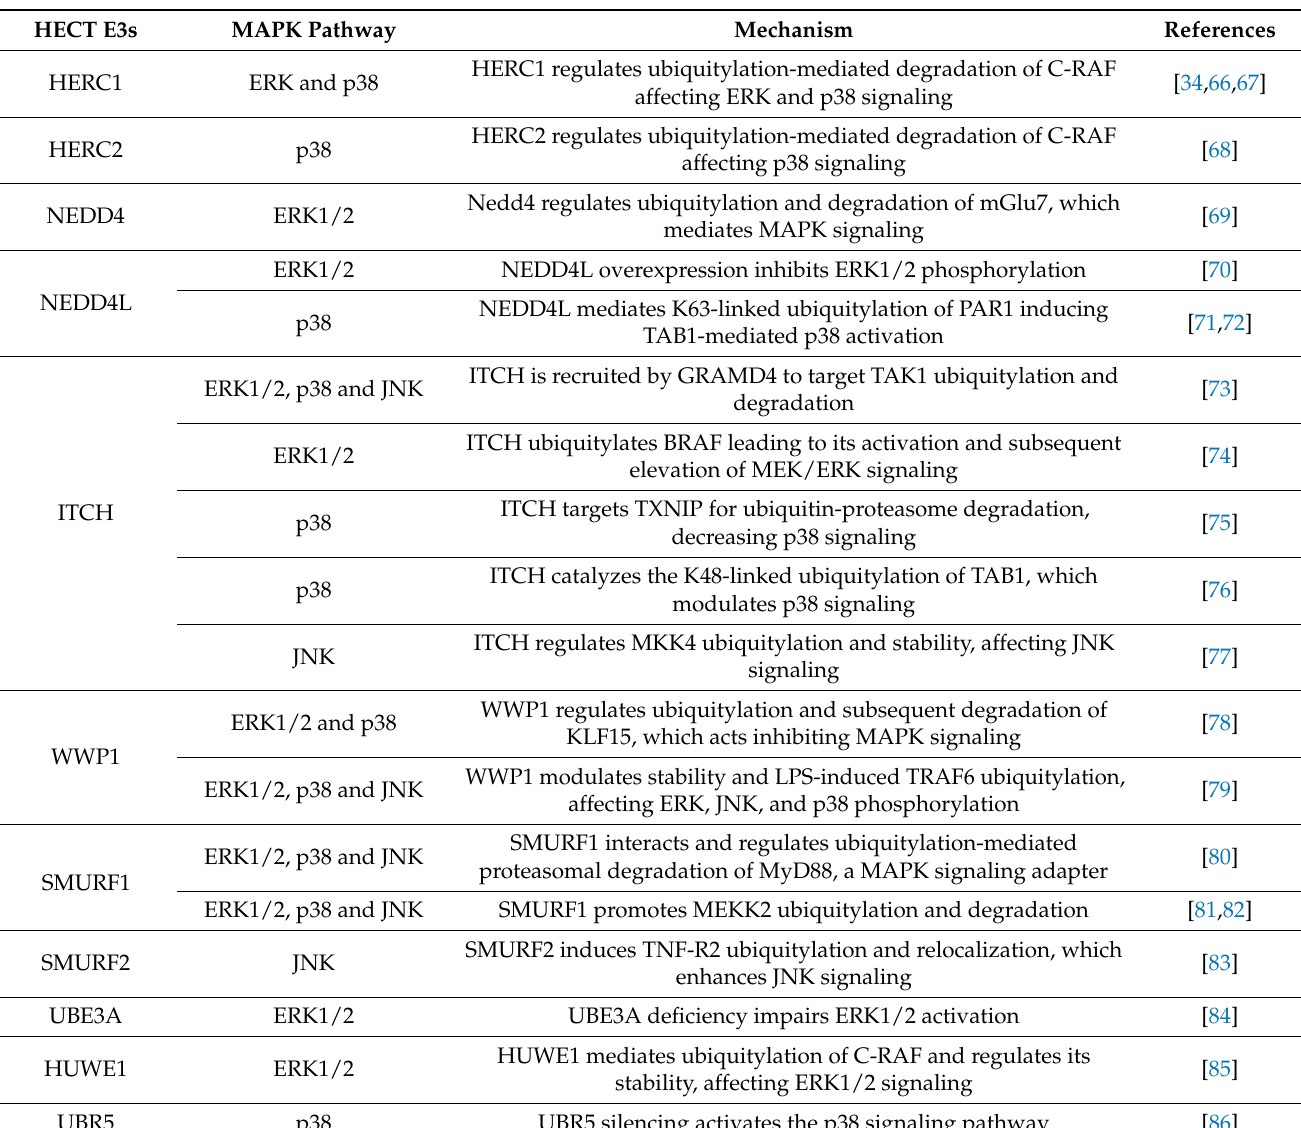
Table 1. HECT E3 ubiquitin ligases regulating MAPK signaling